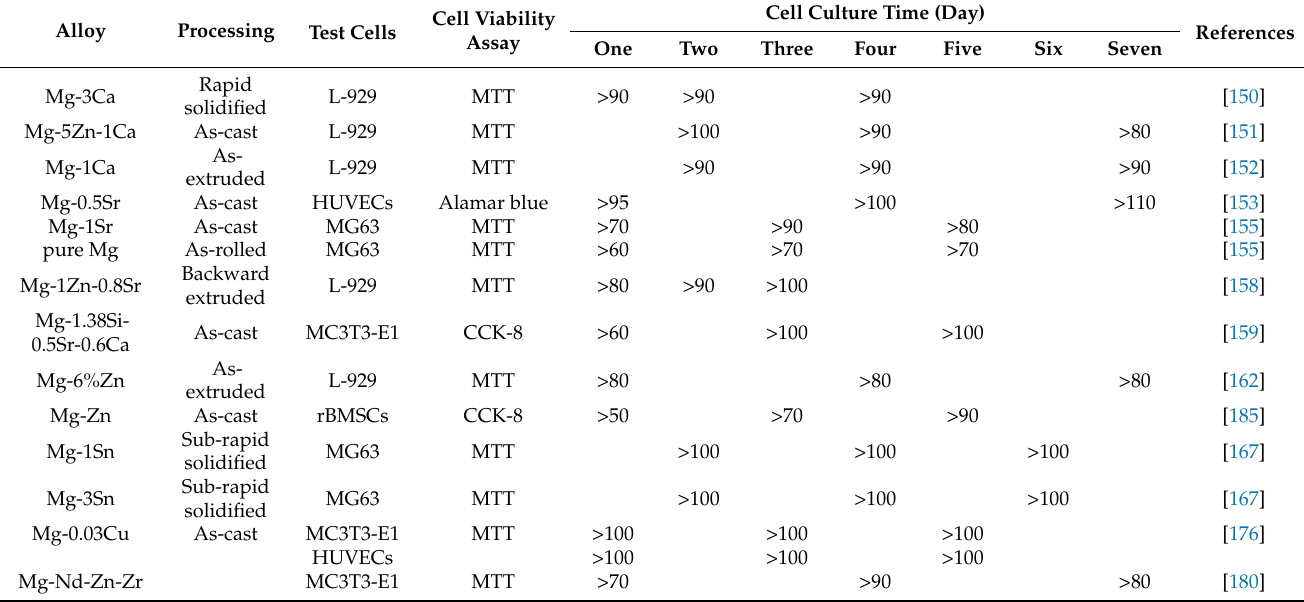
Table 2. In vitro cellular biocompatibility of different magnesium